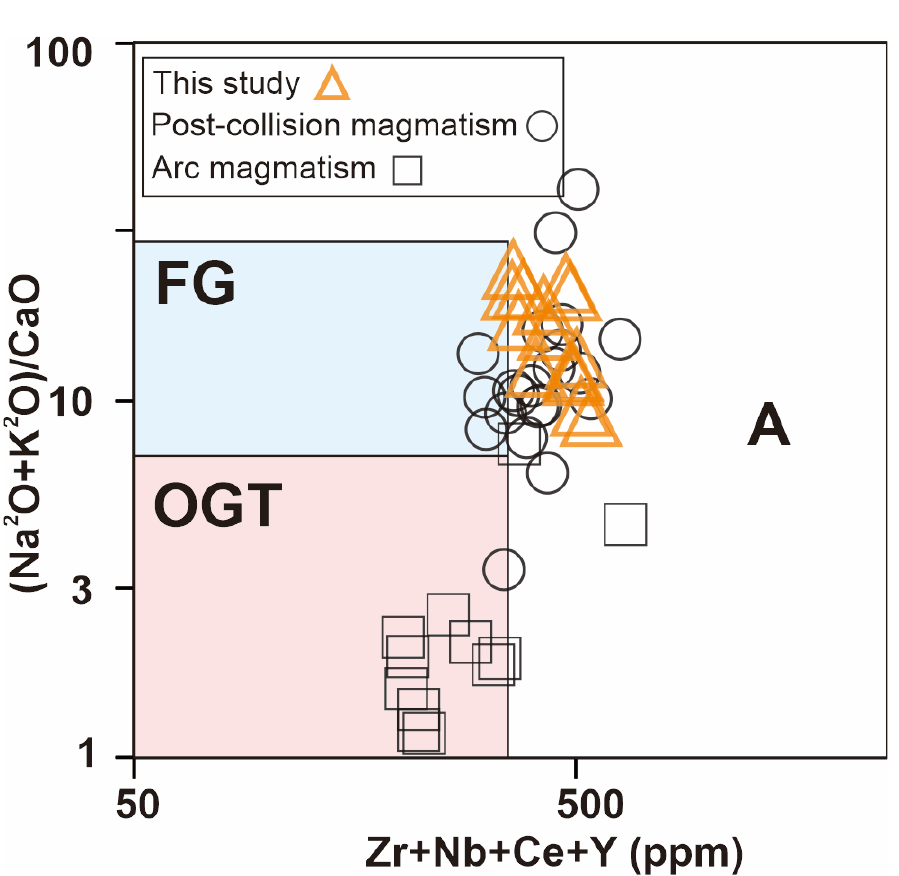
Figure 8. Discriminant diagram for type of granites from the middle Huaniushan arc in the BOB [61]. Geochemical data of post-collision and arc magmatism from [15,18,22–28]. FG = fractionated felsic granites; OGT = unfractionated I- and S-type granites; A = A-type granite.